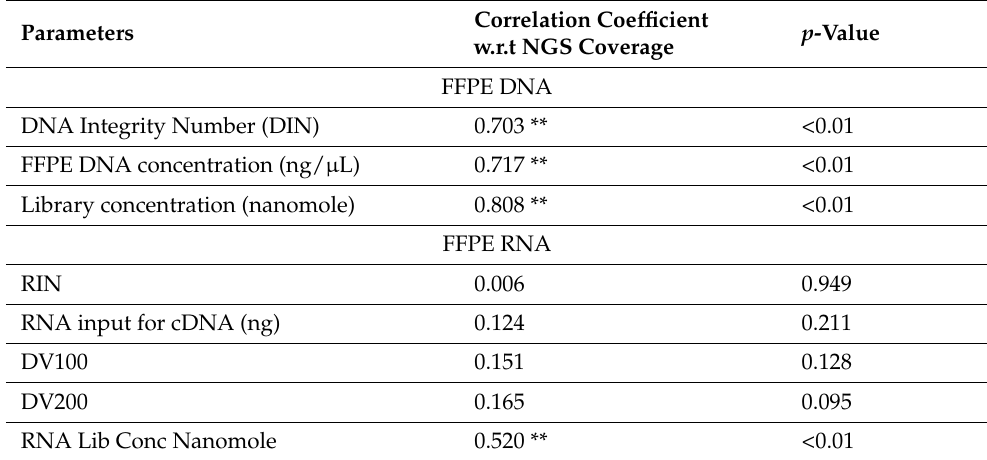
Table 3. Correlation of pre-analytical and post-analytical parameters with coverage status.